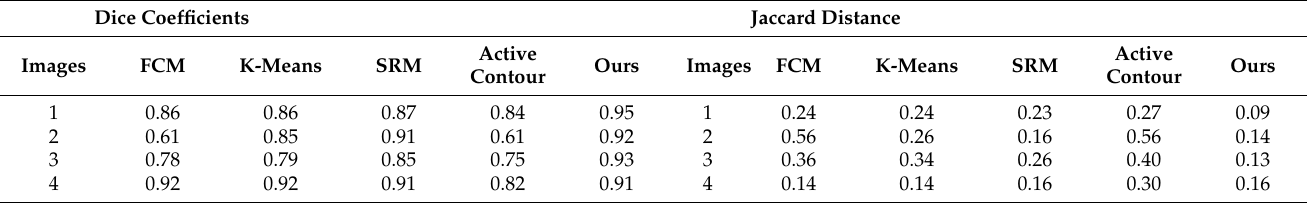
Figure 5. Segmentation results obtained by different methods, the red area is the segmentation result of our method, and the yellow area is the segmentation result of the other four methods, ( a ) input image, ( b ) our method segmentation result, ( c ) FCM segmentation result, ( d ) K-means segmentation result, ( e ) SRM segmentation result, ( f ) active contour segmentation result. Table 2 shows the dice coefficient and Jaccard distance of our proposed method and other methods in 10 groups of experiments.